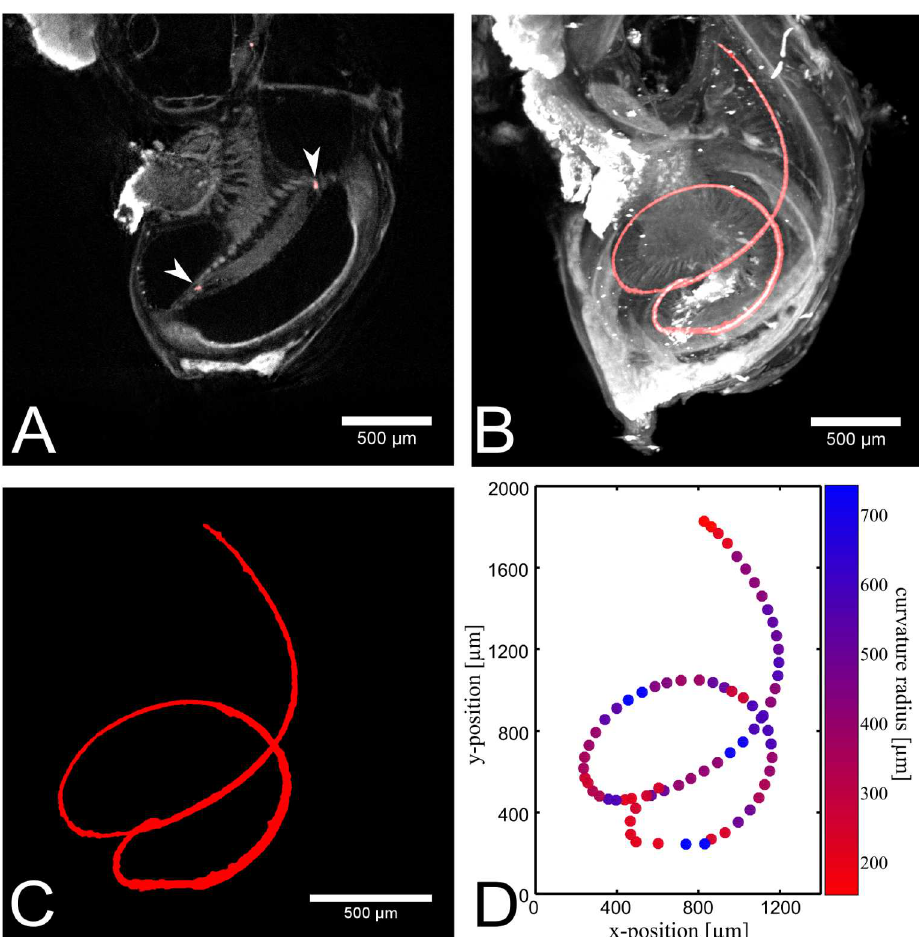
Fig 3. Segmentation of the neurofilament labeling in sample 1. (A) One slice of the segmentation is overlaidwith the reconstructed data. Due to the 3D helicalshape, the neurofilamentappearsin a single slice just as three single points (see arrow heads). (B) Maximum intensity projection of the segmentation, overlayed with the dataset. (C) The segmentedarea is visualizedindividually. (D) The extracted points of the segmented area are plotted. The curvature of the neurofilamentis indicatedby the color map. Blue shows a large curvature radius and red a small curvature radiusin μ m.